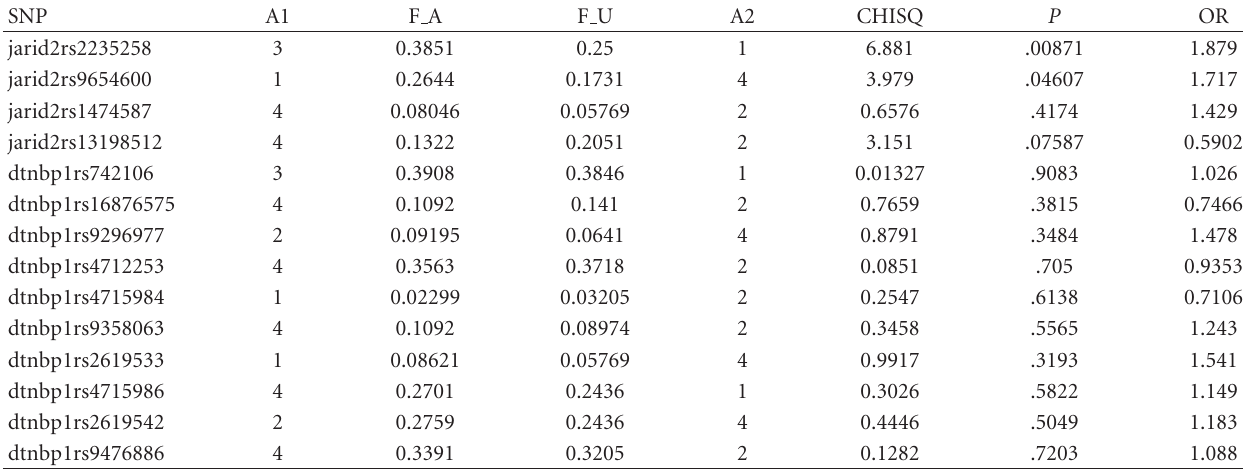
Table 2: Association Analysis of SNPs within JARID2 and DTNBP1 from a homogenous population in Shandong peninsula of China. 177 individuals with nonmissing phenotypes, 89 cases, 88 controls and 0 missing, 87 males, 90 females, 12 of 177 individuals removed for